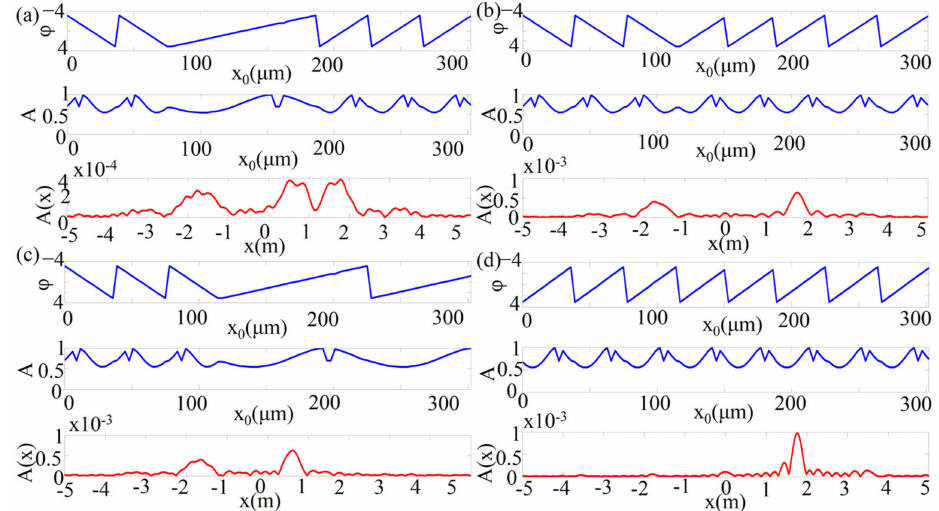
Figure 6. The beam at a propagation distance of 2 m away is calculated by the Fraunhofer diffraction formula. The top and middle parts are the theoretical phase and amplitude of the metasurface. The bottom part is the diffraction amplitude distribution calculated by the Fraunhofer diffraction formula ( a ) Three beams, ( b ) two symmetrical beams, ( c ) two asymmetrical beams, and ( d ) one beam calculated to obtain the distribution of the beams at a propagation distance of 2